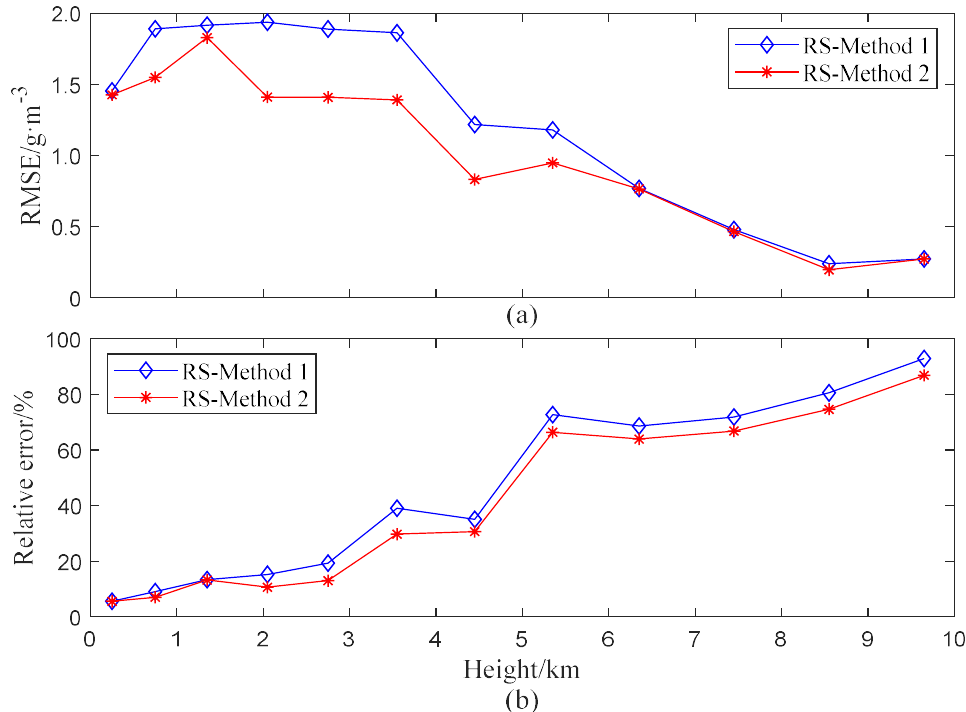
Figure 11. RMSE ( a ) and relative error ( b ) at different altitudes of the tomography results from Methods 1 and 2 with respect to the RS-Method.